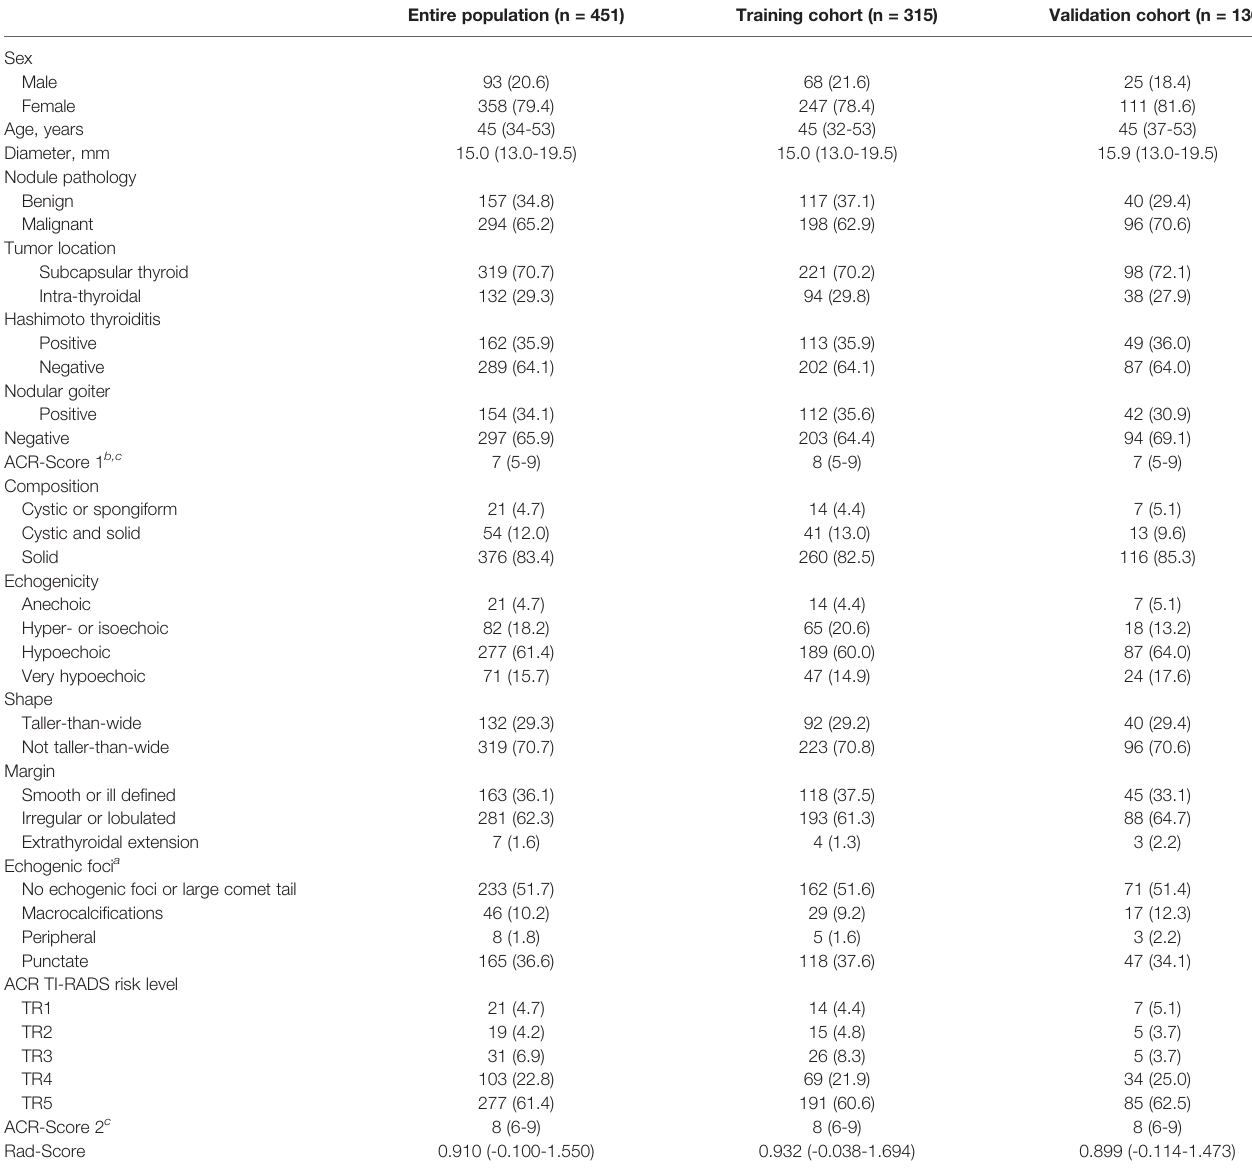
TABLE 1 | Clinicopathological and ultrasonic characteristics of patients in the training and validation